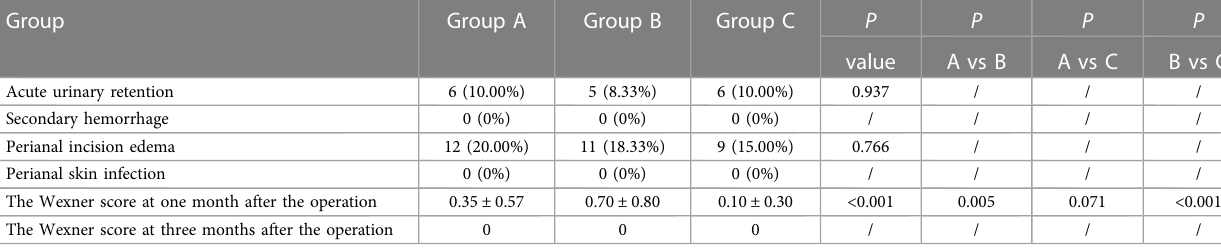
TABLE 3 Comparison of acute urinary retention, secondary hemorrhage, perianal incision edema, perianal skin infection, the Wexner score at one and three months after the operation among three groups.